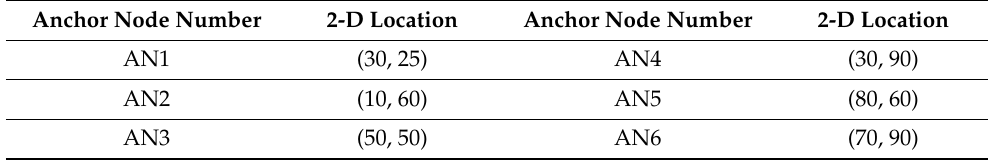
Table 1. Location of the ANs in the considered WSN-defined area.